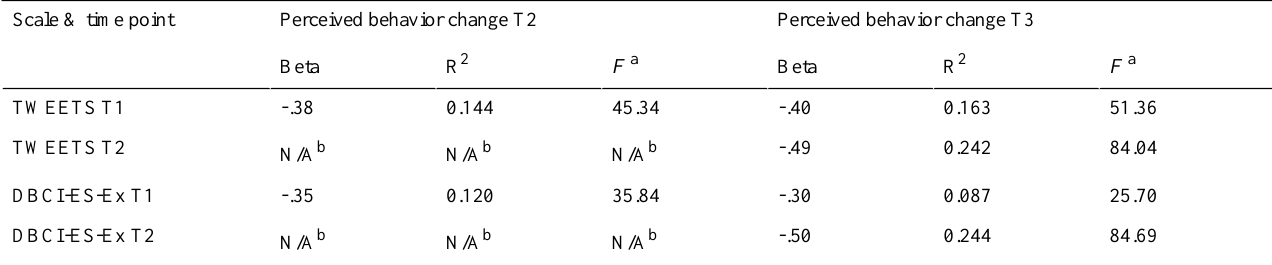
Table 4. Regression analyses with the TWente Engagement with Ehealth Technologies Scale (TWEETS) and the experiential subscale of the Digital Behavior Change Intervention Engagement Scale (DBCI-ES-Ex) to predict perceived behavior